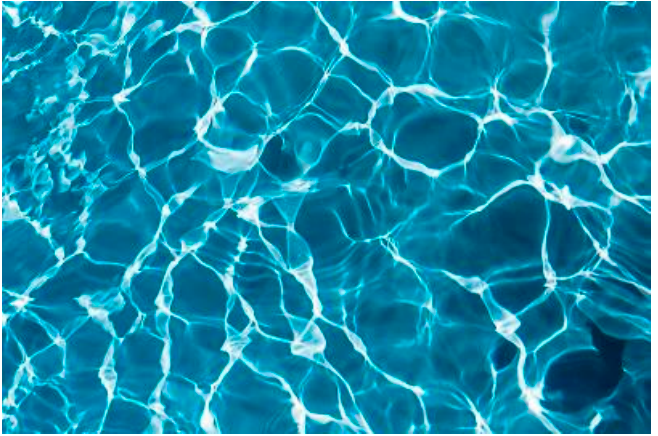
Figure 32. Fast communication of impressionism based on Monet’s painting “Impression”—Scene 7.